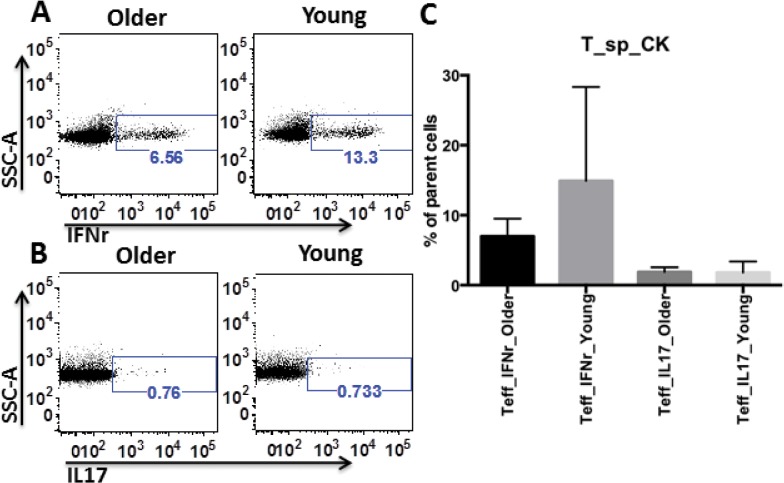
Comparable IFNγ and IL-17 production by splenocytes from young resistants and older progressors.Representative FACS data of IFNγ (A) and IL-17 (B) production by splenic Tcon from an older rapid progressor (as older) and a young resistant (as young). C. Statistical analyses of IFNγ and IL-17 production from older progressors (indicated as older, n = 6) and young resistants (as young, n = 5). Unpaired 2-tailed T test was used, and no significant difference between the two groups was found.